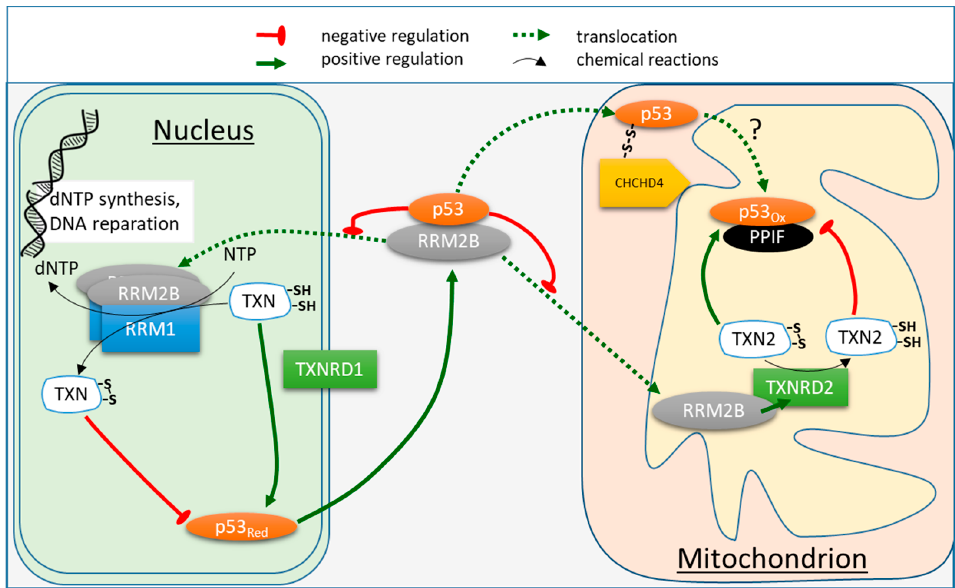
Figure 6. Interplay between the non-nuclear heterologous complexes of p53 and thiol-disulfide oxidoreductases. The names of cellular compartments are underlined. Cytosolic p53 sequesters RRM2B subunit of ribonucleotide reductase in cytosol. Under stress conditions, the p53-dependent expression of RRM2B (a p53 target gene) would cause accumulation of free RRM2B, which translocates to nucleus and mitochondria for the on-site synthesis of deoxyribonucleotides (dNTPs) as part of the DNA damage response program. The formation of active ribonucleotide reductase complex comprising RRM1 and RRM2B in nucleus is in accord with available experimental data [111–114]. Cytosolic thioredoxin (TNX) is a reducing substrate for the dNTPs synthesis on one hand, and a reductant of p53 disulfides on the other hand. The TNX shift to the disulfide form would decrease the dithiol form of p53 required for its transcriptional activity. The TNX shift to the reduced form, on the contrary, would increase the dithiol form of p53, thus increasing its transcriptional activity. P53 binds with far higher affinity to RRM2B promoter than to the proapoptotic gene promoters [45]. This hierarchy supports p53-dependent DNA repair without activating an apoptotic response. In the mitochondrial intermembrane space, p53 forms a mixed disulfide with CHCHD4, probably involved in p53 transport to mitochondrial matrix [16]. In mitochondrial matrix, RRM2B activates mitochondrial thioredoxin reductase (TXNRD2) upon their interaction [117]. The increased reduction of mitochondrial thioredoxin (TNX2) may not only stimulate the RRM2B-supported mitochondrial DNA repair, similar to that in nucleus, but also promote formation of the active reduced form of intramitochondrial p53. TNX2 and p53 compete for their complexes with PPIF [118], providing for the redox-dependent regulation of apoptosis. The p53-PPIF complex promotes apoptosis [54], the TNX2-PPIF complex promotes survival [118].